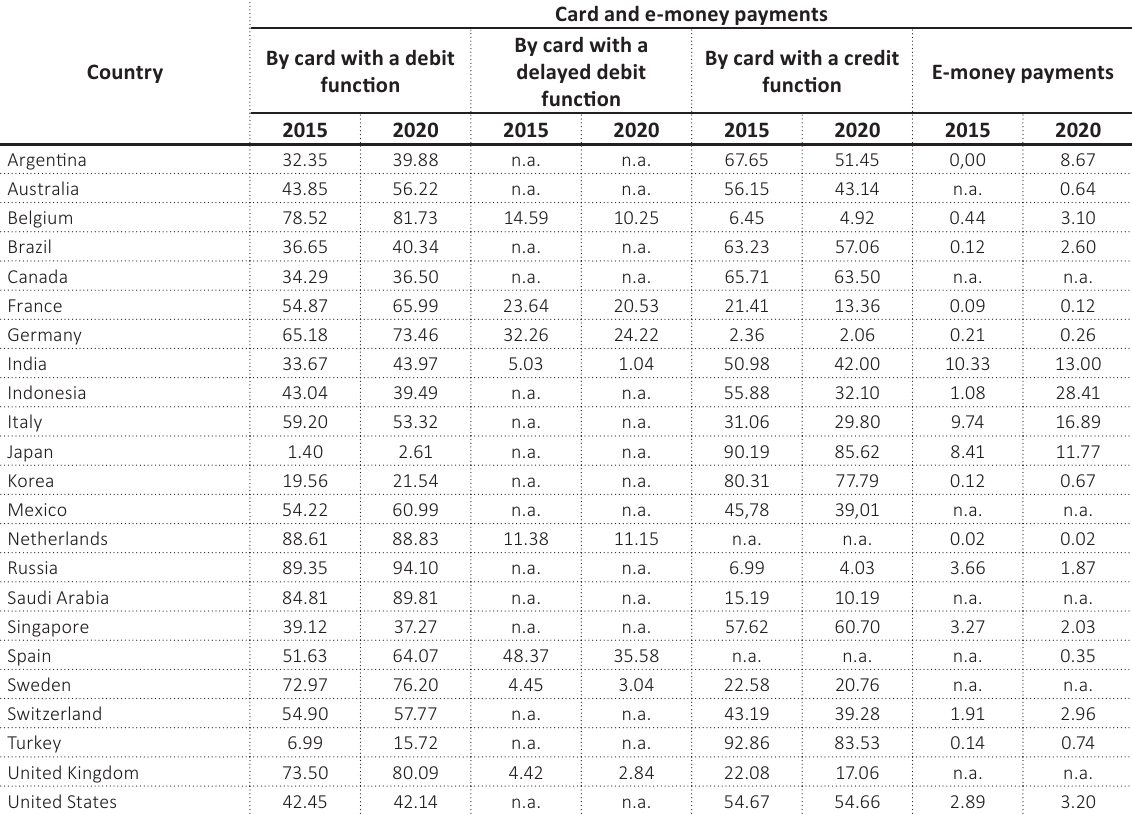
Table 2. Number of mobile money transactions per 1,000 adult citizens in selected countries of the world in 2015–2021,